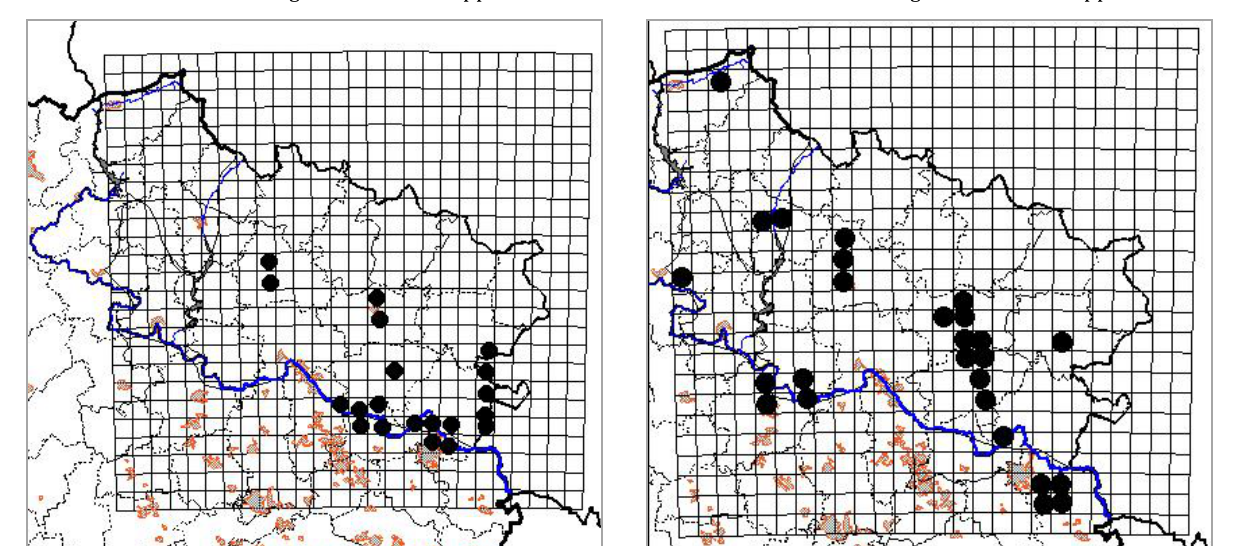
Fig. 6. The map of the distribution of Ambrosia artemisiifolia L. in the Starobilsk grass-meadow steppe